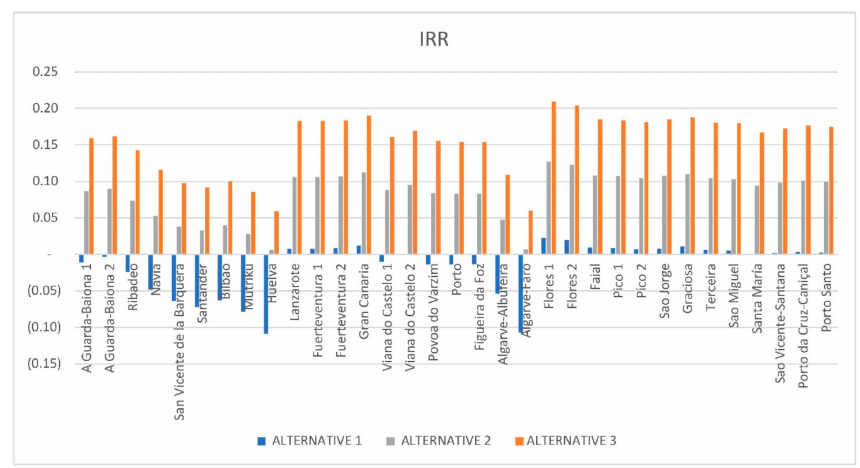
Figure 11. Internal rate of return (IRR) results.